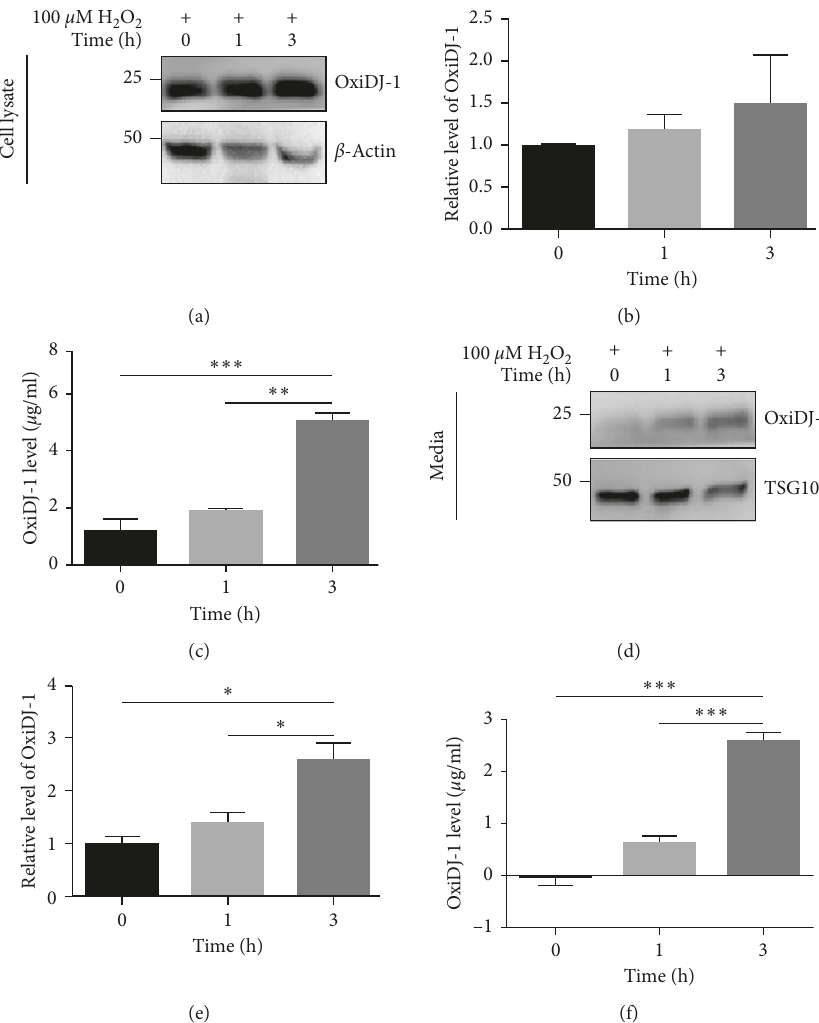
Figure 2: Detection of OxiDJ-1 treated with H 2 O 2 in HEK293T cell lysates or cultured media. HEK293T cells were treated with 100 μ M H 2 O 2 for 0, 1, and 3h, and their cell lysates (a) or culture media (d) were subjected to Western blot assay. A quantitative analysis of cellular (b) or media (e) OxiDJ-1 levels, which were normalized by their β -actin (b) or TSG101 (e) levels, was done. Increased OxiDJ-1 levels in cell lysates (c) or media (f) were detected by ELISA. n 3, duplication for ELISA, One-way (cid:31)